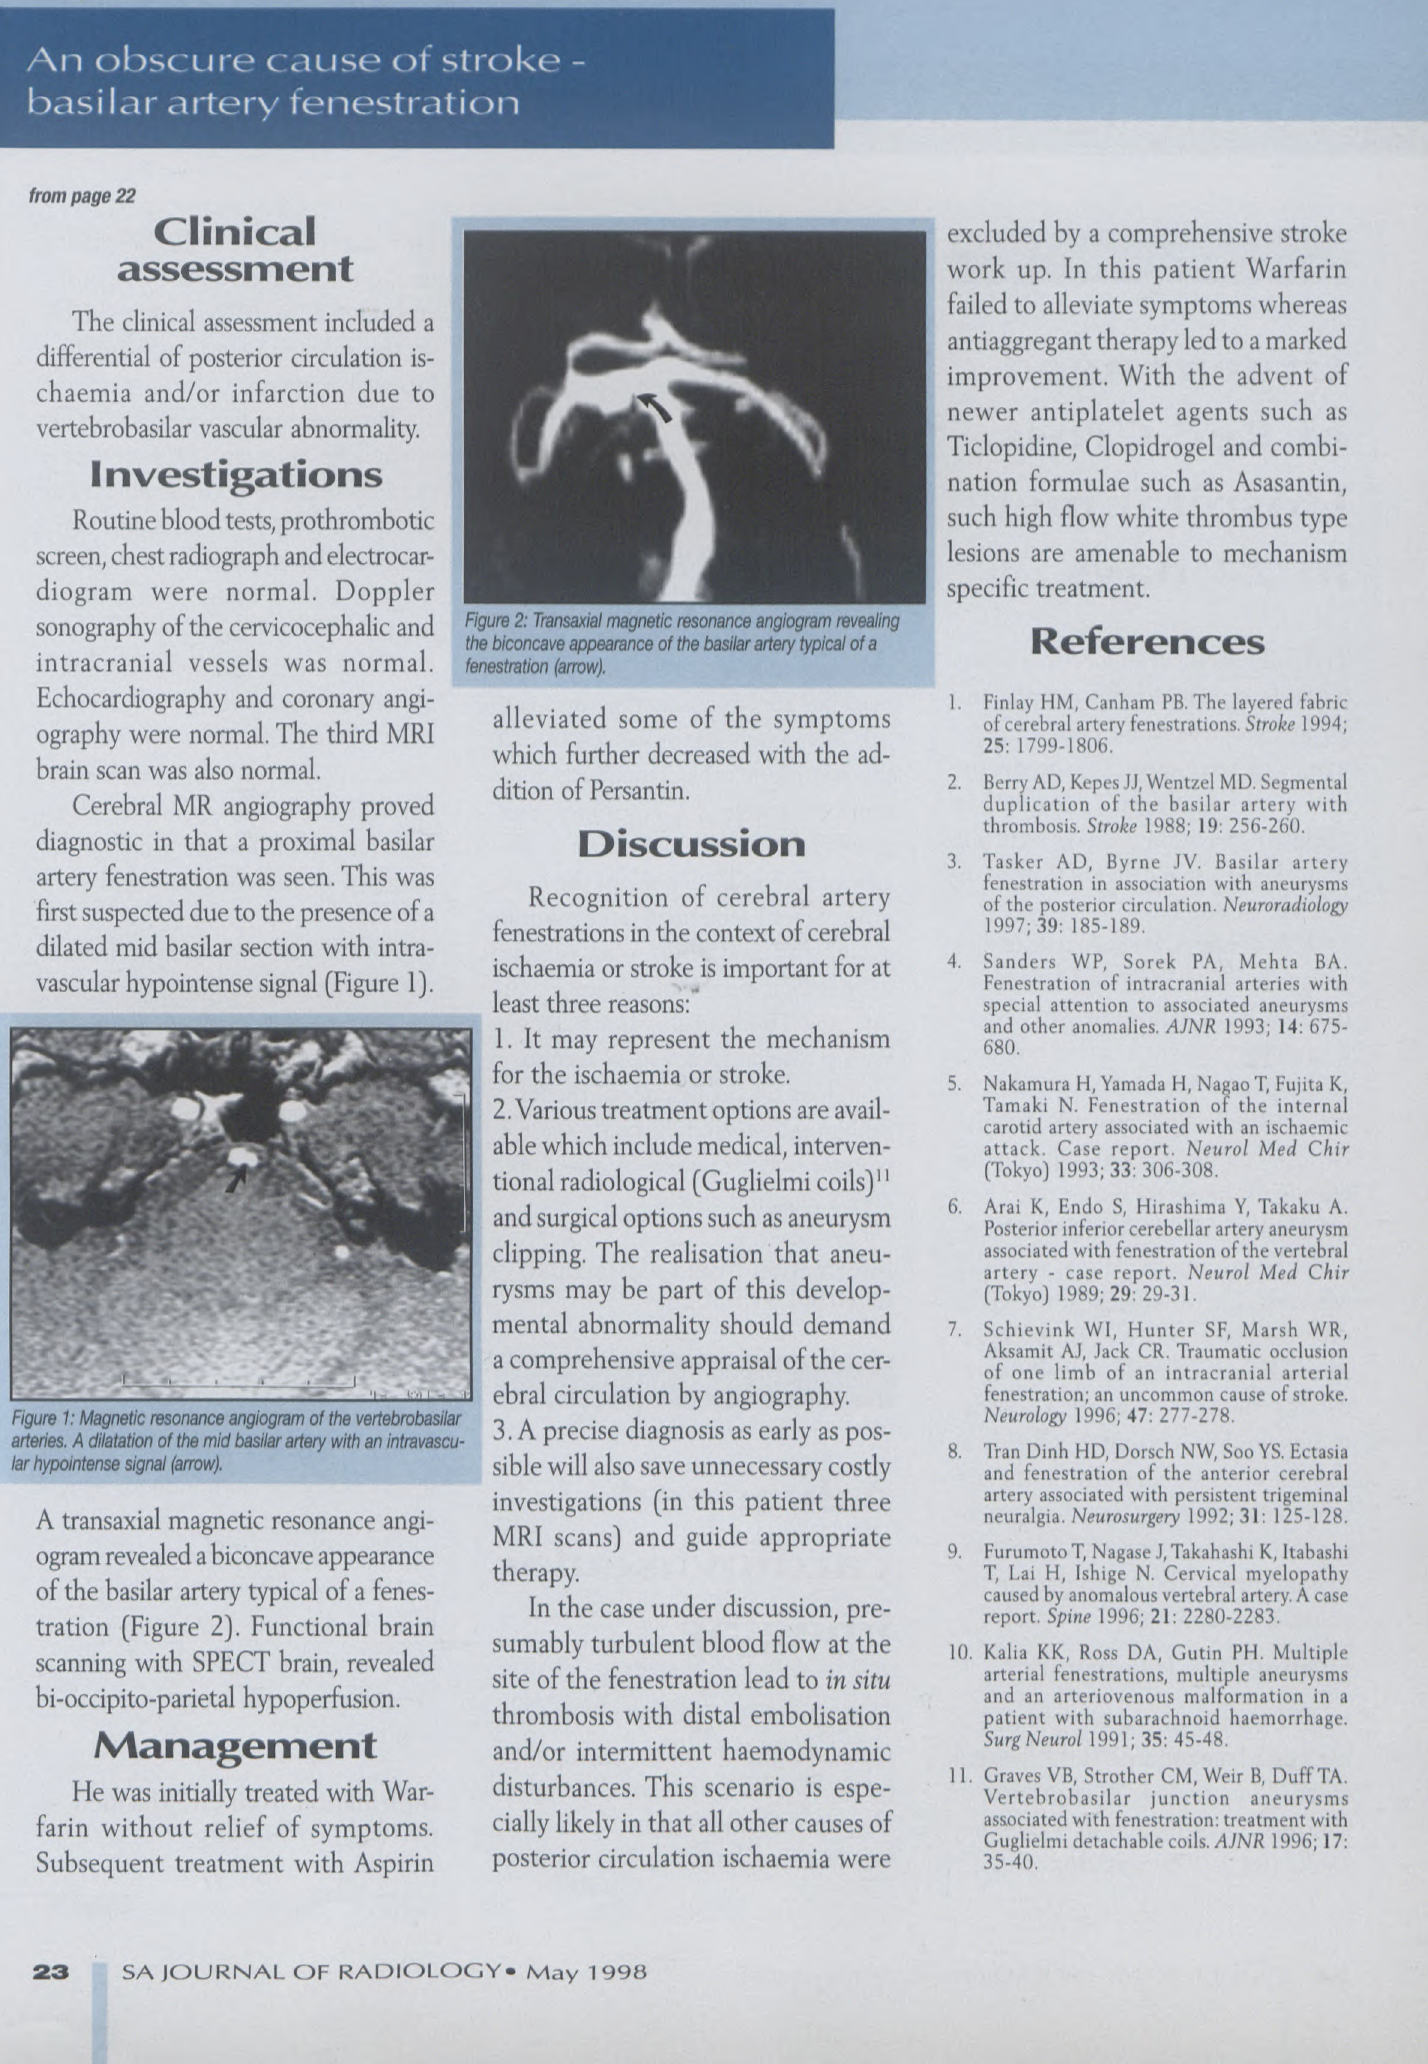
Figure 1: Magnetic resonance angiogram of the vertebrobasilar arteries. A dilatation of the mid basilar artery with an intravascu- lar hypointense signal (arrow).